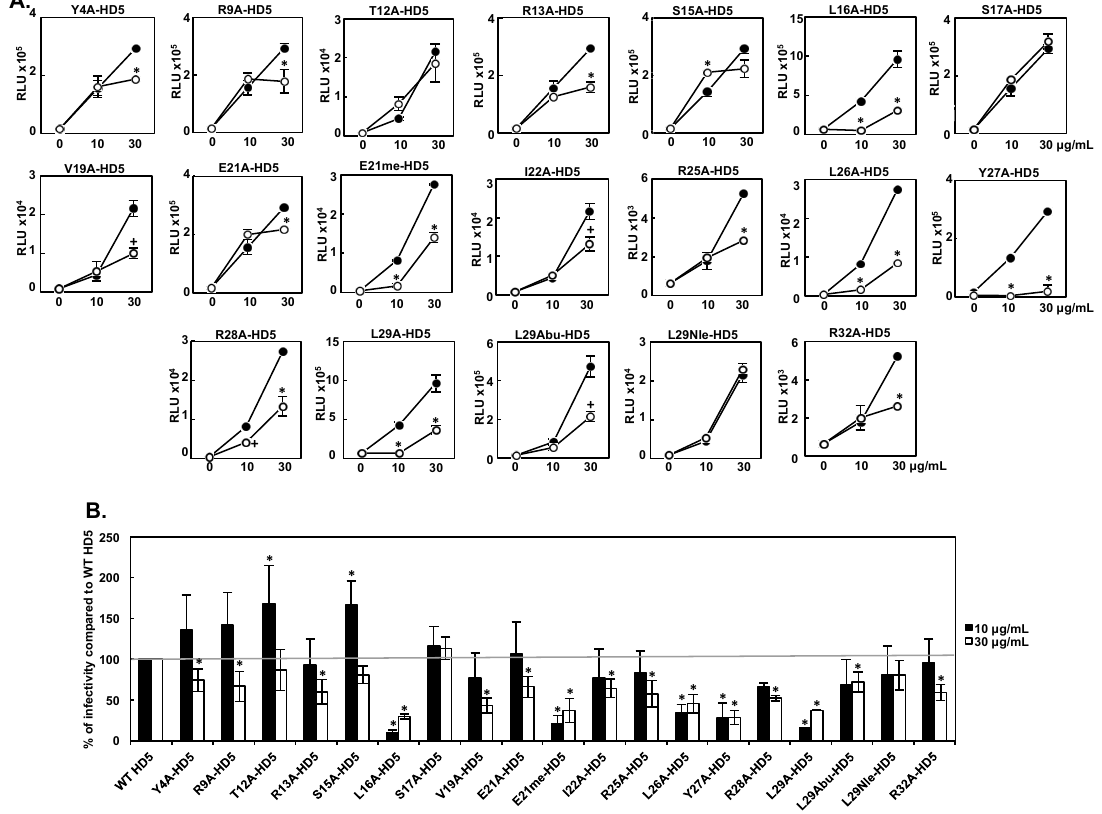
Figure 1. Effect of human α -defensin 5 (HD5) mutants on human immunodeficiency virus (HIV) infection-enhancing activity. Wild type (WT) HD5 or HD5 mutants were incubated with serum-free HIV-1 JR-FL for 1 h. HeLa-CD4-CCR5 cells were then incubated with the defensin–virus mixture for 2 h. After washing off unbound viruses, cells were cultured for 48 h before measuring infection by luciferase activity. ( A ) Results of a paired independent experiment for WT HD5 (filled circles) and each HD5 mutant (open circles) are shown. The relative light units (RLUs) of infected cells without defensin treatment were 410–860 or 2–7 × 10 4 on a MiniLumat LB9506 luminometer (EG&G Berthold) or a PerkinElmer 2300 EnSpire Multimode Plate Reader, respectively. The signal of uninfected cells was not detectable. Data are means ± standard deviation (SD) of triplicate samples and represent seven independent experiments. * p < 0.05, WT HD5 versus HD5 mutants at the same concentration; Student’s t -test. After Bonferroni correction, the difference between WT HD5 versus V19A-HD5 (30 µ g/mL), I22A-HD5 (30 µ g/mL), R28-HD5 (10 µ g/mL) and L29Abu-HD5 (30 µ g/mL) was not significant (+ p > 0.05); ( B ) Data represent the average of the relative percent of enhanced infectivity by mutants to WT HD5 at the same concentration from seven independent experiments. * p < 0.05, WT HD5 versus HD5 mutants at the same concentration; one-way analysis of variance (ANOVA) with Bonferroni post-test.